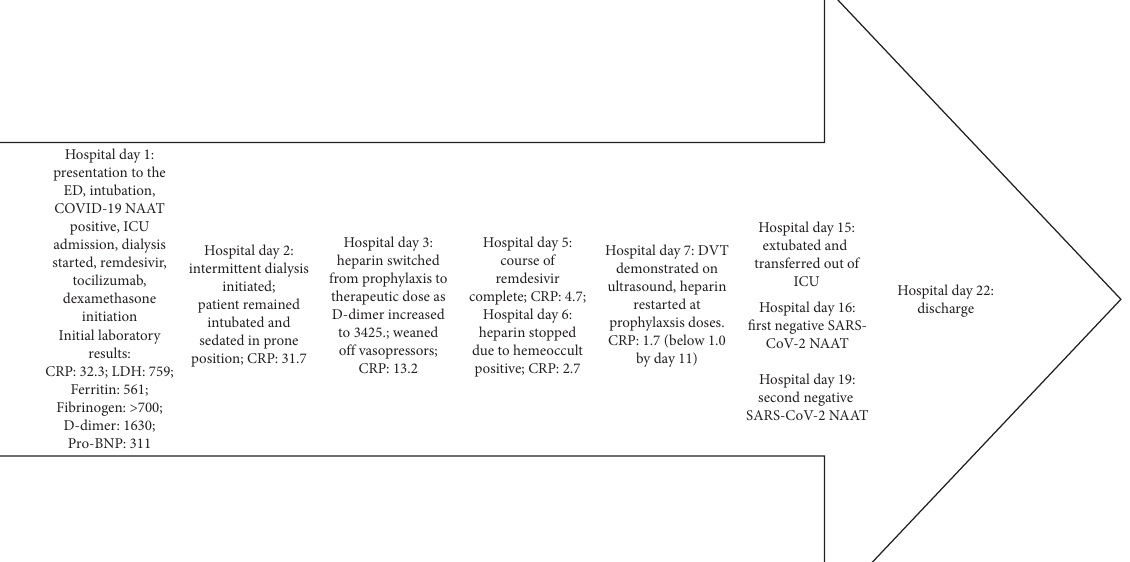
Figure 1: Timeline of hospital course. CRP: C-reactive protein (mg/dL); LDH: lactate dehydrogenase (U/L); Pro-BNP: pro-beta natriuretic protein (pg/mL). Units: D-dimer: ng/mL; ferritin: ng/mL; fibrinogen: